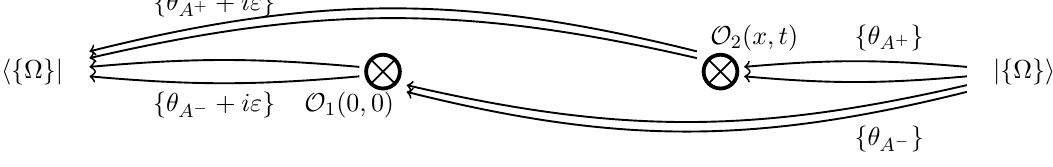
Figure 3 . Graphical interpretation of the clustering property of the two-point function. In the j x j ! 1 limit only those terms survive in the two-point function, where f (cid:22) g = ; and the parti- tionings of the index sets A and B are complementary, leading to a factorization of the two-point